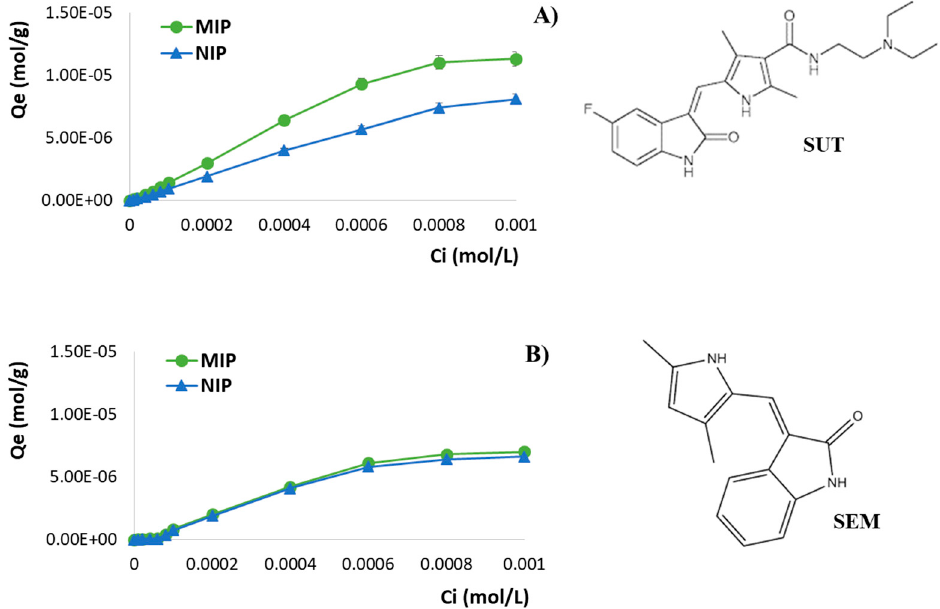
Figure 4. Adsorption isotherms of ( A ) SUT and ( B ) SEM on imprinted and non-imprinted particles and chemical structures of Sunitinib (SUT) and Semaxanib (SEM).